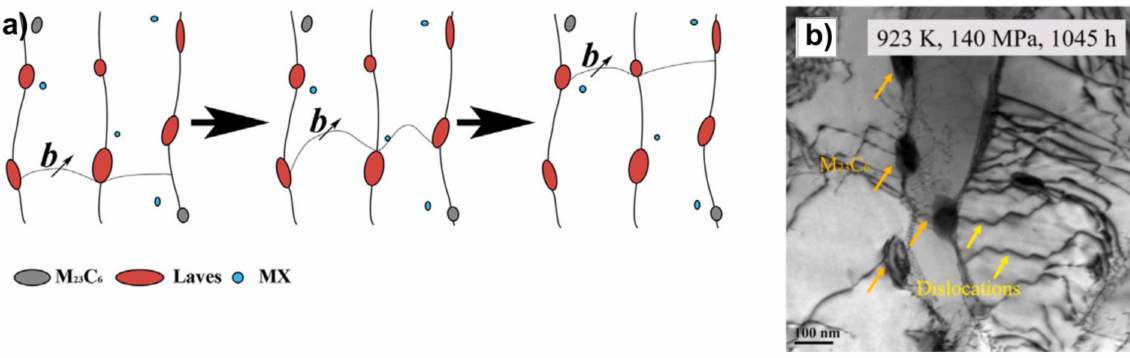
Figure 21. Scheme showing dislocation glide along the laths in the 9Cr-1.5W-3Co steel during transient creep when small Laves phase particles precipitate on the lath boundaries ( a ). Reprinted with permission from Ref. [18], Copyright 2018 Elsevier. TEM micrograph showing the motion of dislocations in the lath interior in the presence of M 23 C 6 carbides on the lath boundaries in the G115 steel after creep rupture test at 650 ◦ C and 140 MPa for 1045 h ( b ). Reprinted with permission from Ref. [78]. Copyright 2021